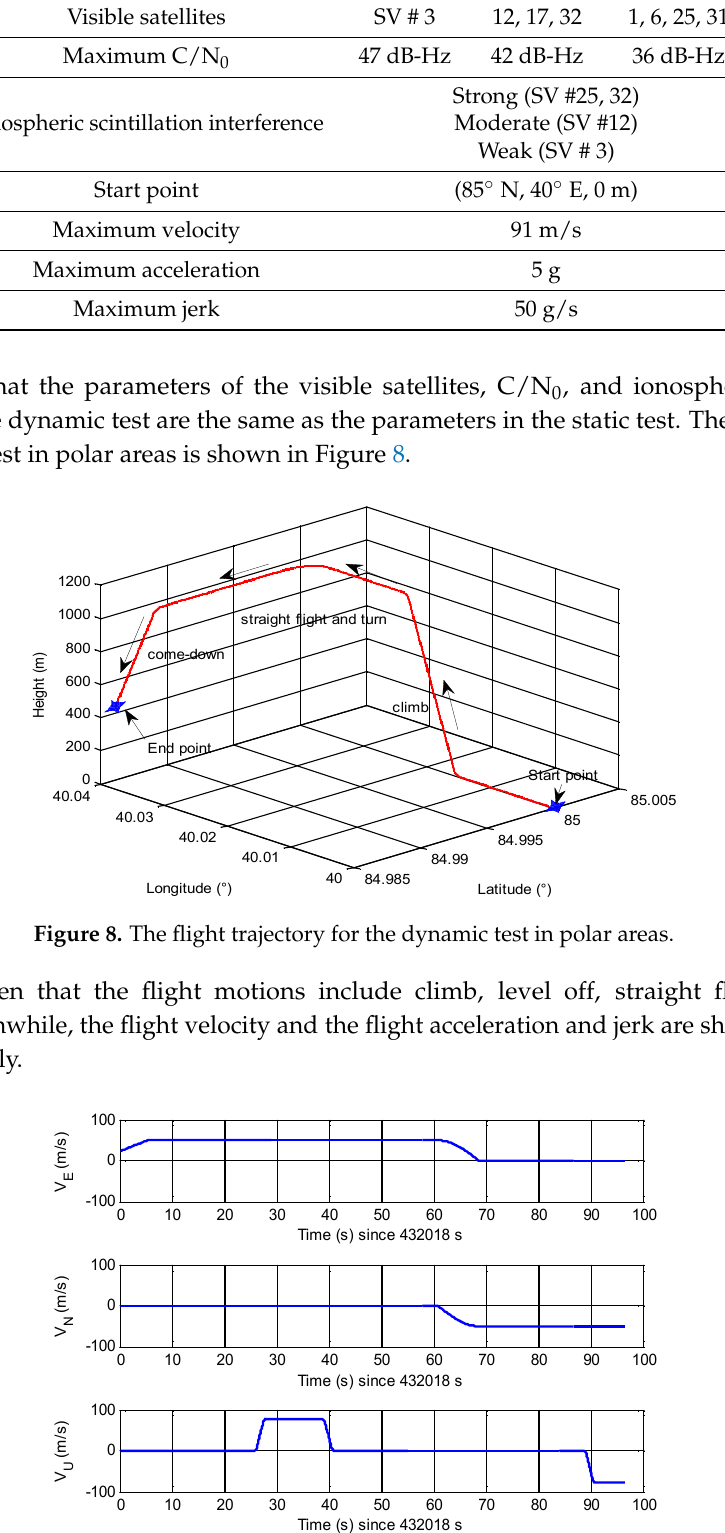
Figure 9. The flight velocity of the dynamic test in polar